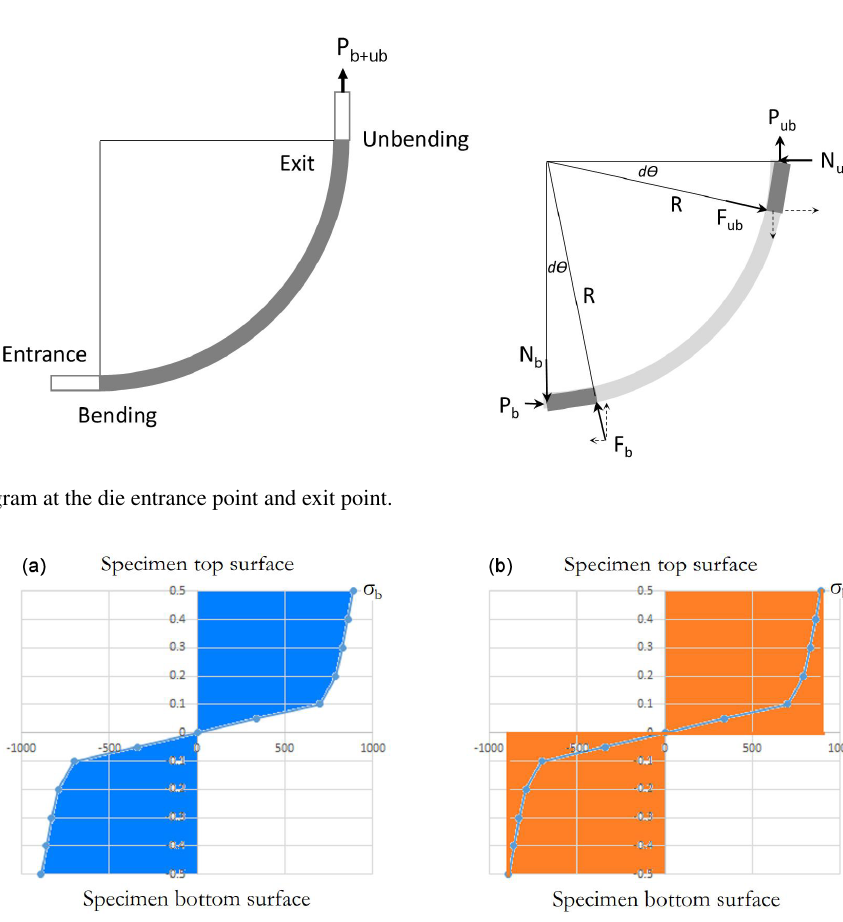
Figure 11. Illustration of through-thickness stress distribution (a) and their approximation (b) .